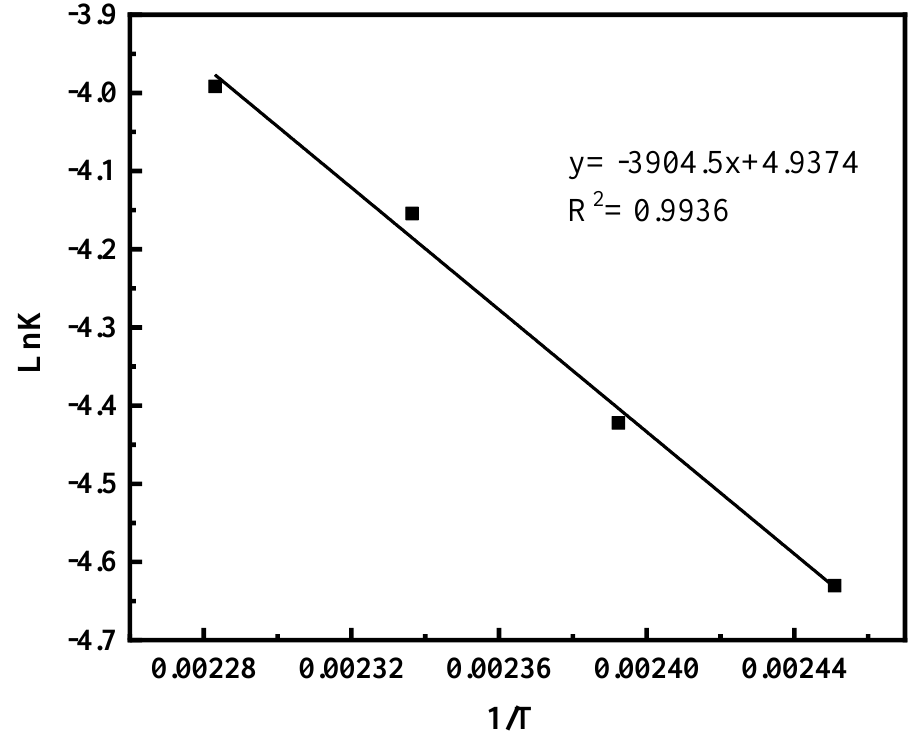
Figure 6. Positive reaction rate constant versus temperature.